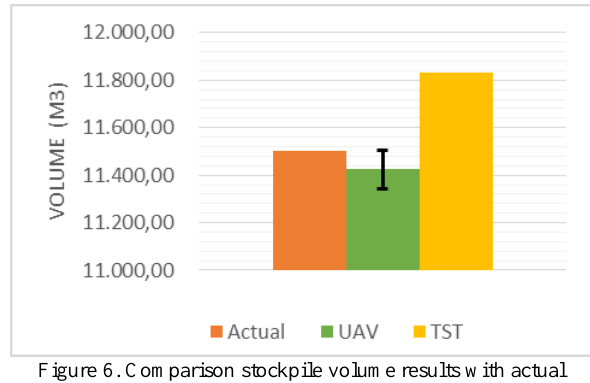
Figure 6. Comparison stockpile volume results with actual volume